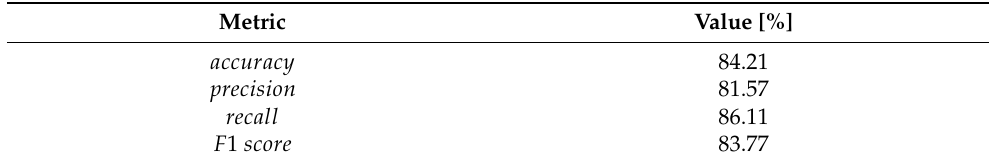
Table 1. ResNet18 real HS dataset classification